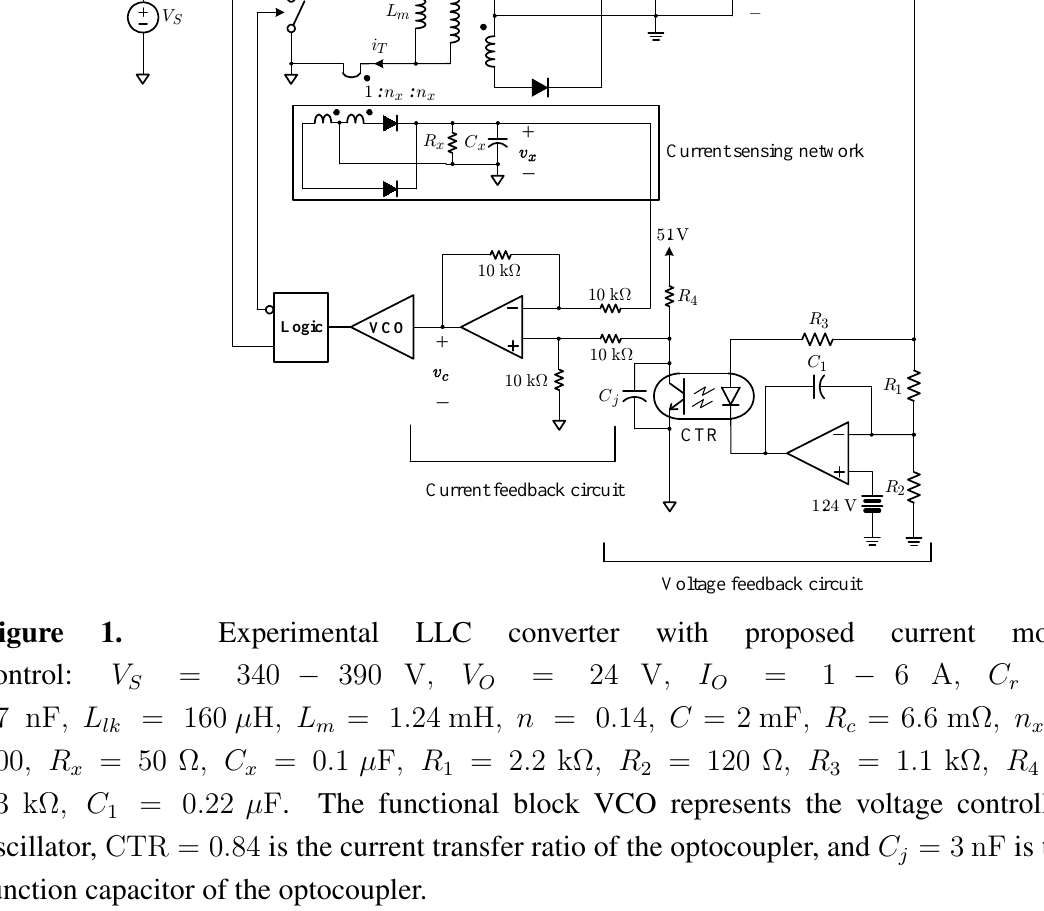
Figure 1. Experimental LLC converter with proposed current mode = 340 − 390 V , V = 24 V , I = 1 − 6 A , C = control: V S O O r 47 nF , L = 160 µ H , L = 1 . 24 mH , n = 0 . 14 , C = 2 mF , R = 6 . 6 mΩ , n = lk m c x 100 , R = 50 Ω , C = 0 . 1 µ F , R = 2 . 2 kΩ , R = 120 Ω , R = 1 . 1 kΩ , R = x x 1 2 3 4 13 kΩ , C = 0 . 22 µ F . The functional block VCO represents the voltage controlled 1 = 3 nF is the oscillator, CTR = 0 . 84 is the current transfer ratio of the optocoupler, and C j junction capacitor of the